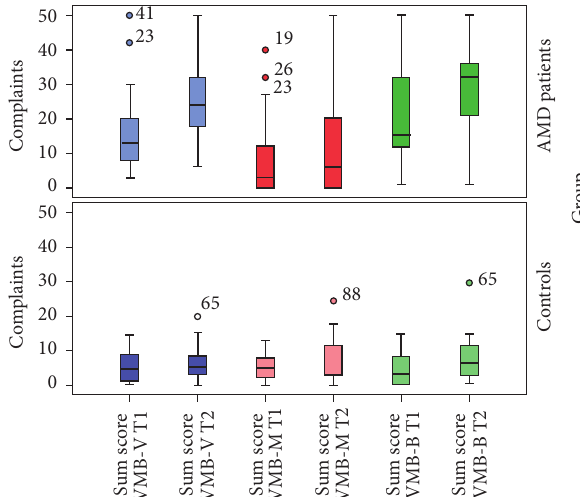
Figure 2: Visual, musculoskeletal, and balance complaints for AMD patients and referents with age-normal vision at baseline and at follow-up 4 years later. Boxplots, showing quartiles and median values, with whiskers showing range and numbered